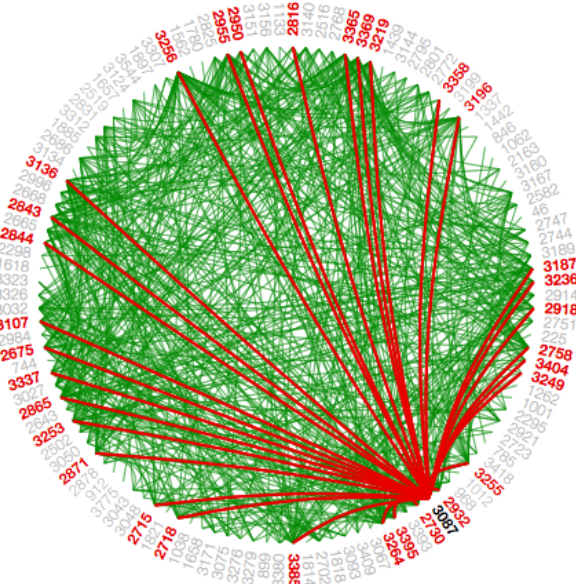
Figure 12. Represents the Mouse-hover interaction in hierarchical edge bundling